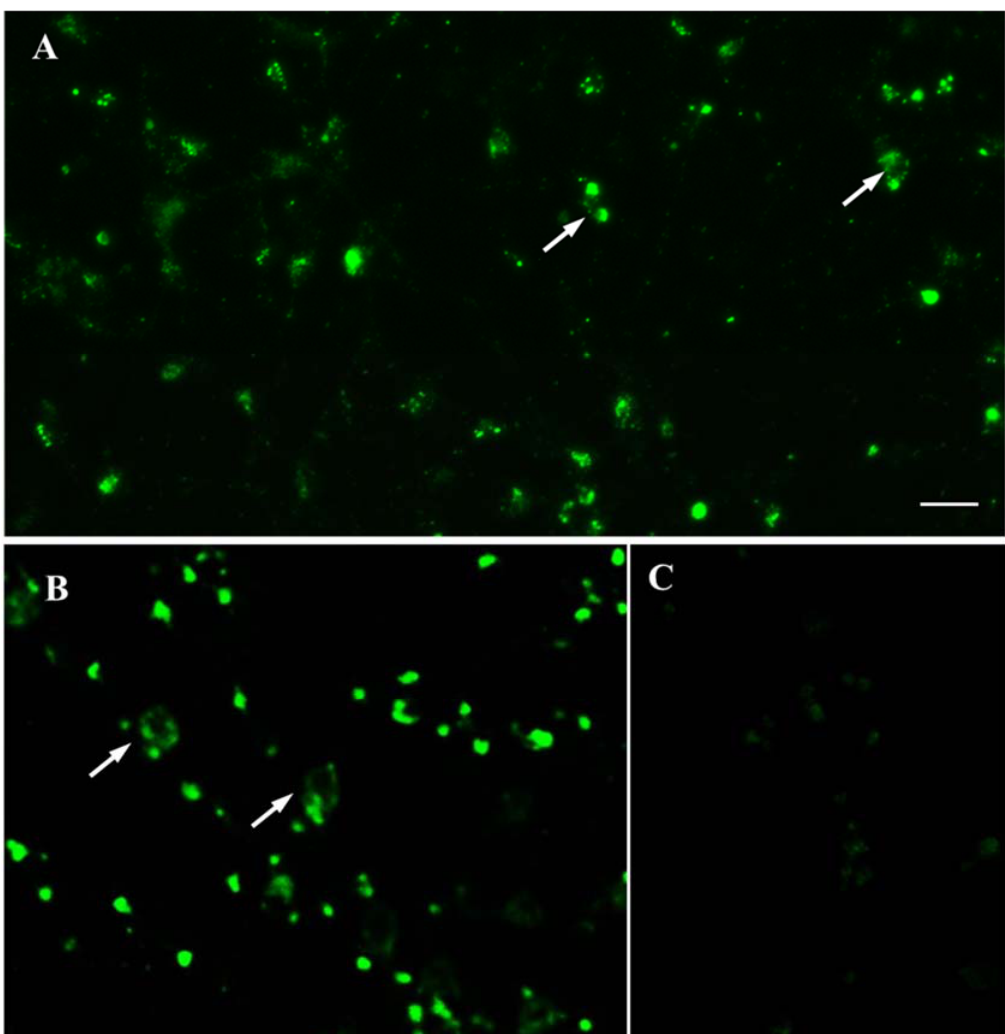
Figure 7. Fluorescence microscopy of living mouse metencephalic cells (7th day of culturing) ( A ) and LUHMES cells (7th day of differentiation) ( B ) following 60 min incubation (staining) with GBR-BP at a concentration of 50 nM, as well as of LUHMES cells 72 h after the incubation with 50 nM GBR-BP for 60 min ( C ). Objective magnification = × 20 (Plan-Neufluar). Arrow, GBR-BP-stained cell. Bar = 25 µ m for all photos.